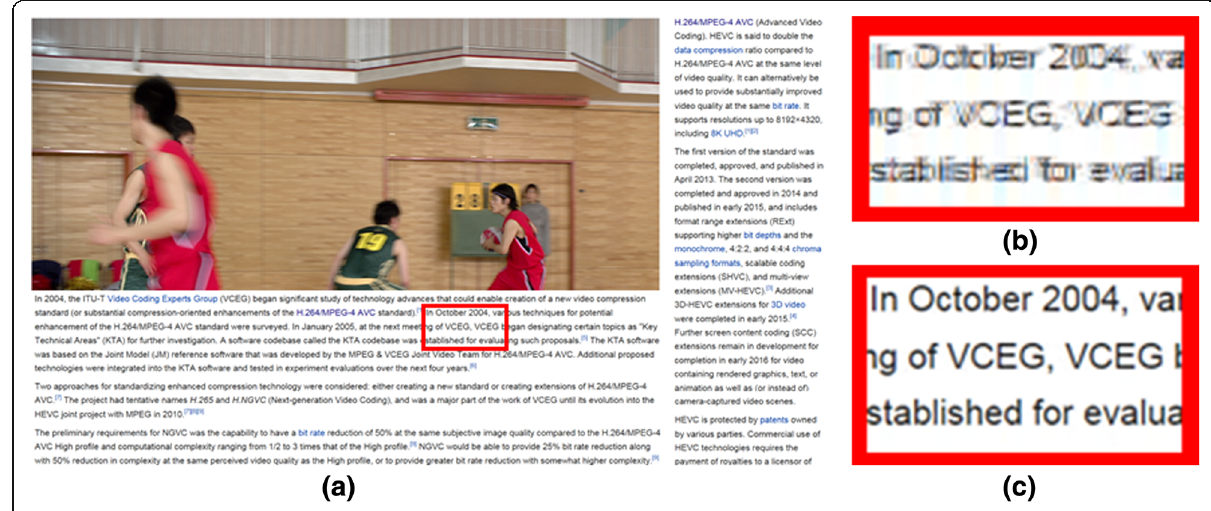
Fig. 15 Results of text line images in split mode. a Input image. b Edrisinghe ’ s [29] result. c Proposed BRC ’ s